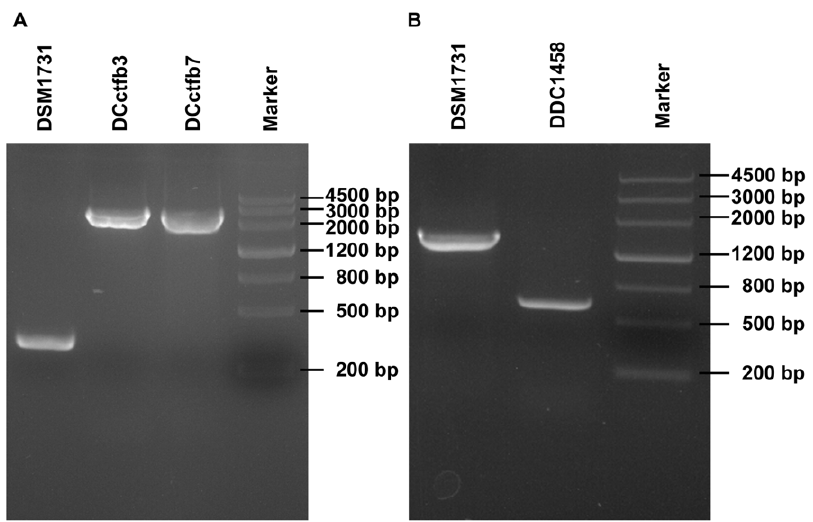
Figure 5. Construction of ctfAB deletion mutants. A. Identification of an insertion mutant by PCR using primers Ct-5 and CTFB-3 flanking the target site; B . Identification of the deletion mutant by PCR using primers Pro2-5 and Pr2-3.